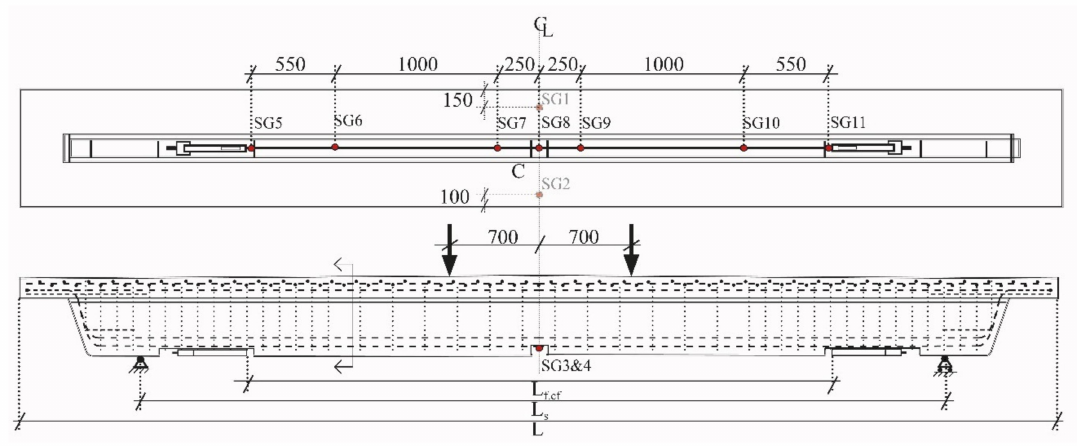
Figure 1. Concrete T-beam dimensions, load setup, and applied monitoring. Note: Units in mm.